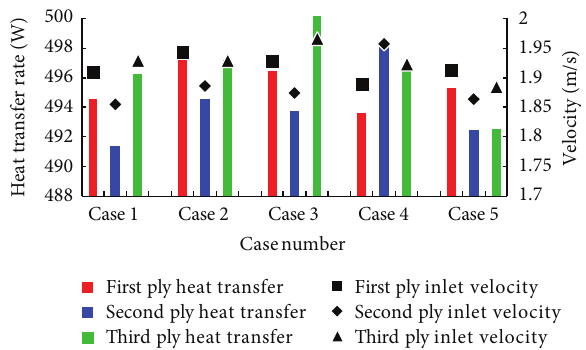
Figure 5: Variation of heat transfer rate with respect to inlet velocity at 5 L/min in various cases.